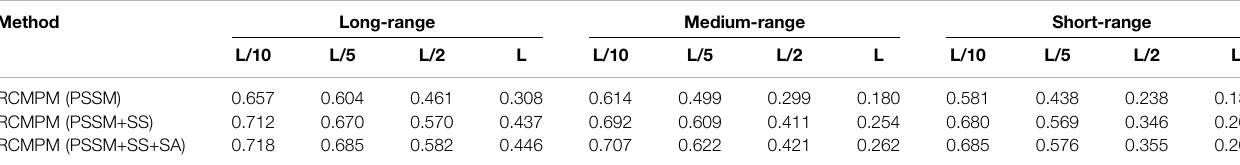
TABLE 7 | Comparison results for feature combinations by using the rough CCMpred contact